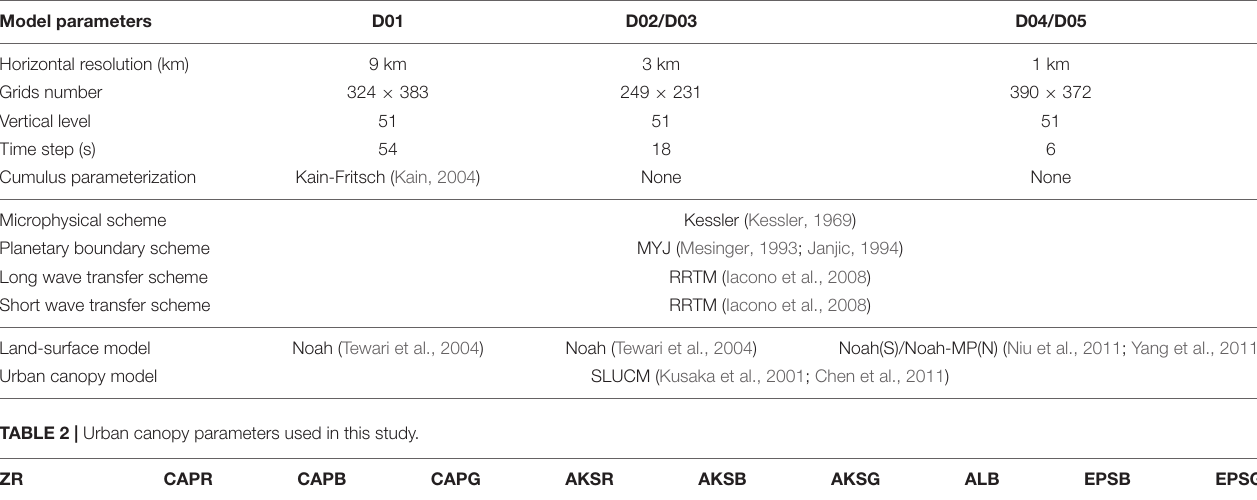
TABLE 1 | The main parameters used in the WRF model setup.